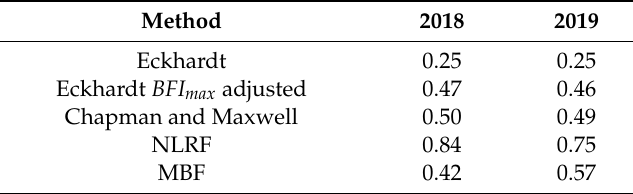
Table 4. BFI values of individual hydrological